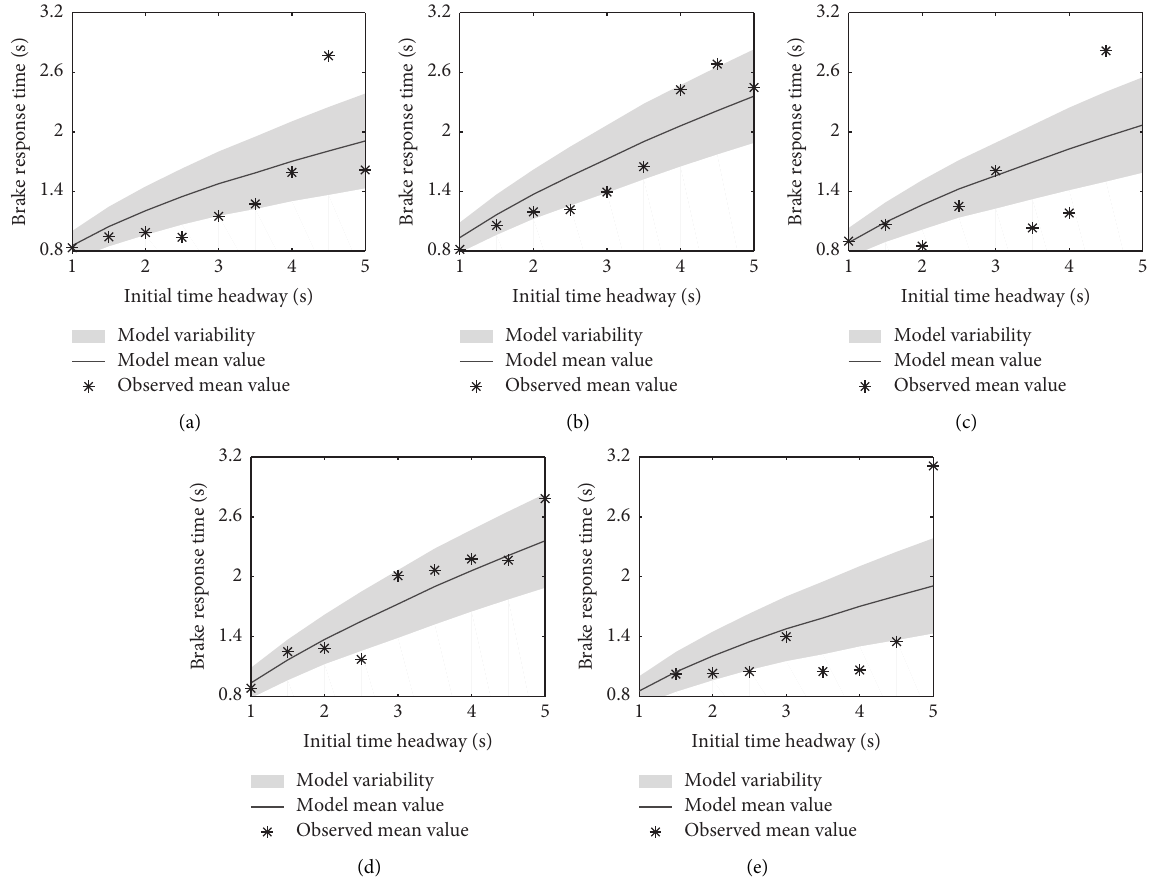
Figure 6: Simulation results versus observations obtained from simulator experiments, using τ − 1 . _ θ . (a) No phone. (b) Hands-free (simple). (c) Handheld (simple). (d) Hands-free (complex). (e) Handheld